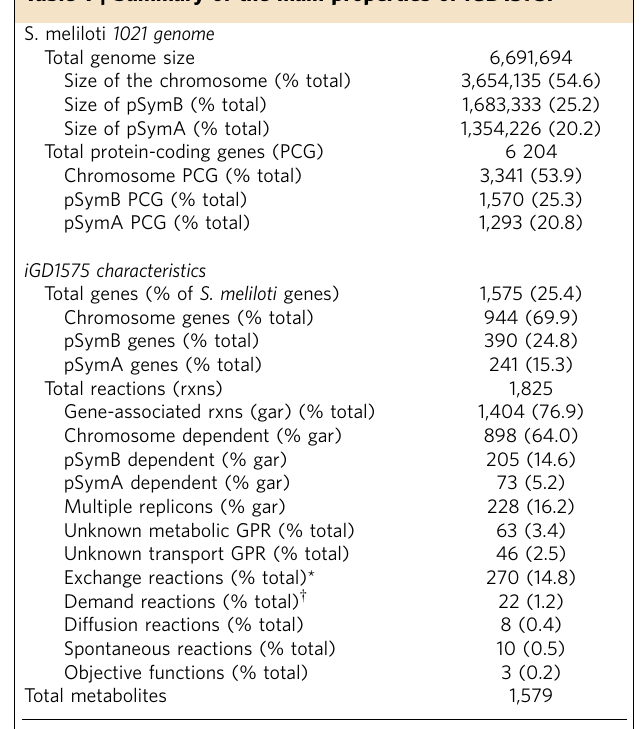
Table 1 | Summary of the main properties of iGD1575.